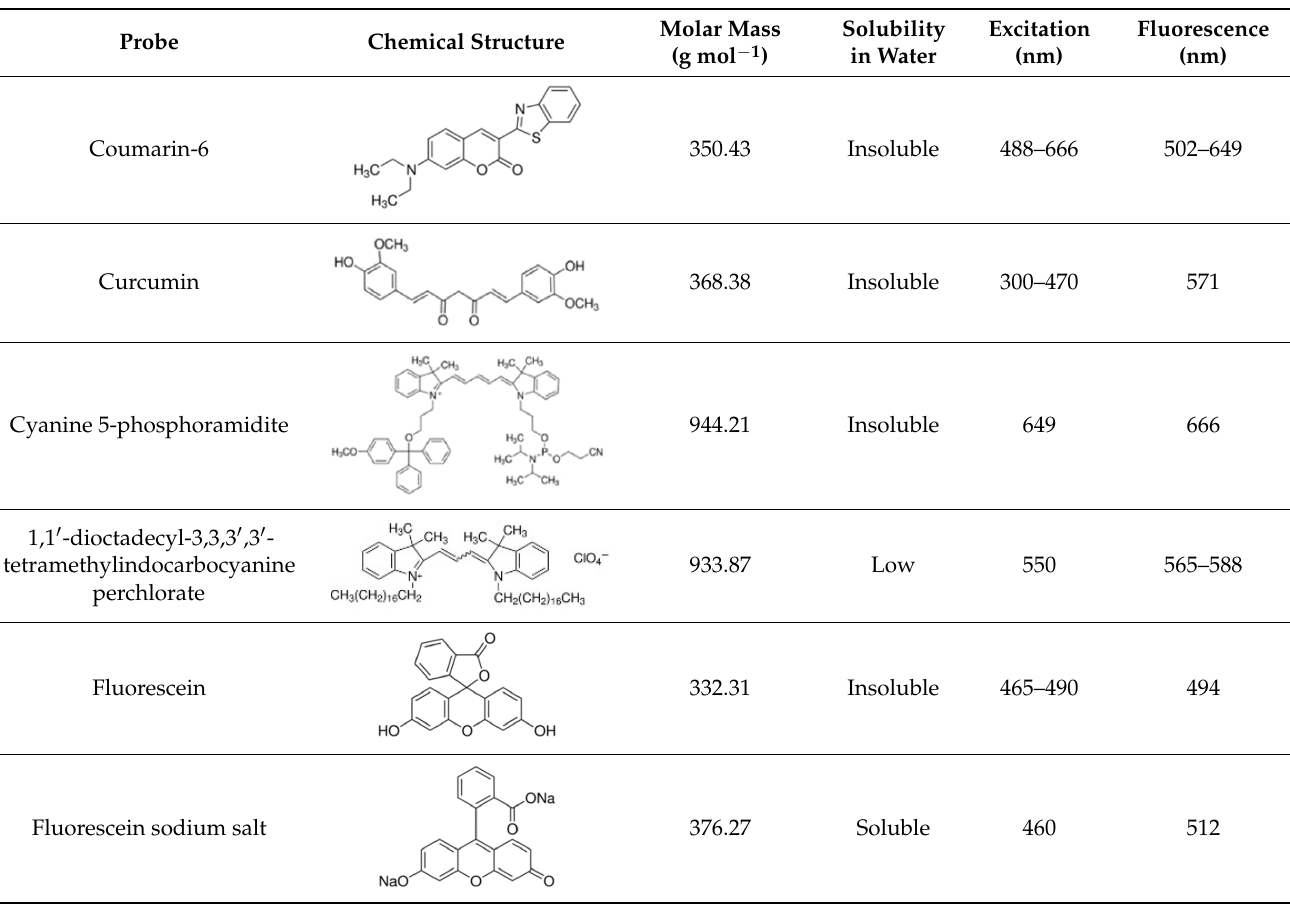
Figure 2. Timeline of the fluorescence Figure 2. Timeline of the fluorescence discovery. Figure 2. Timeline of the fluorescence discovery. Figure 2. Timeline of the fluorescence discovery. Figure 2. Timeline of the fluorescence discovery. Figure 2. Timeline of the fluorescence discovery. Table 2. Physico-chemical properties of the main fluorescent probes used in ocular bioimaging. Table 2. Physico-chemical properties of the main fluorescent probes used in ocular bioimaging. Table 2. Physico-chemical properties of the main fluorescent probes used in ocular bioimaging. Table 2. Physico-chemical properties of the main fluorescent probes used in ocular bioimaging. Probe Probe